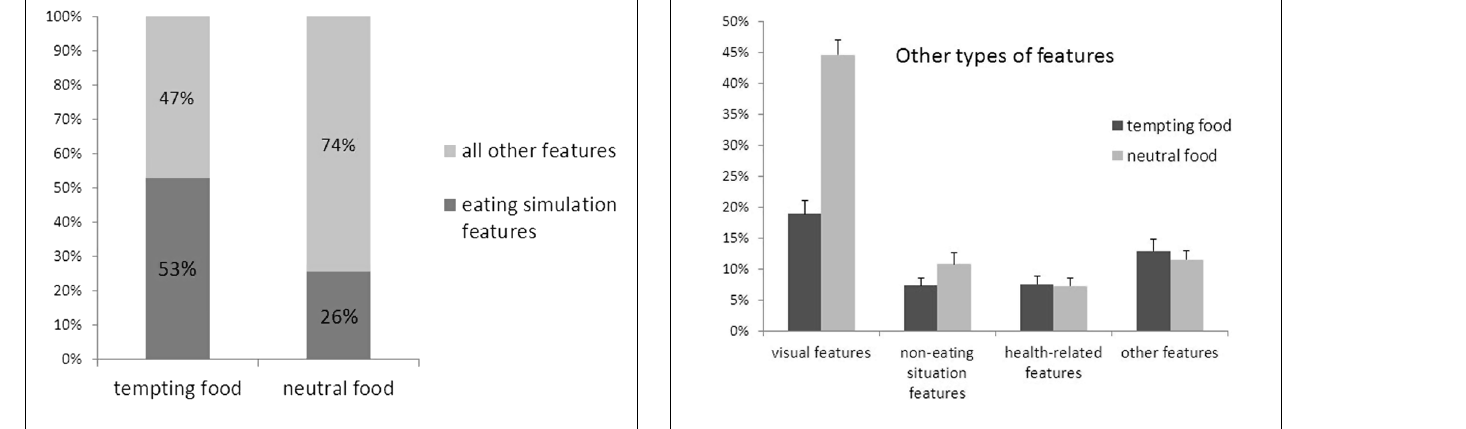
FIGURE 3 | Percentages of each of four types of other features generated for tempting and neutral food. Error bars denote the standard error of the mean. An asterisk marks a significant difference between tempting and neutral food ( p < 0.001), and a “ † ” marks a marginally significant difference ( p <